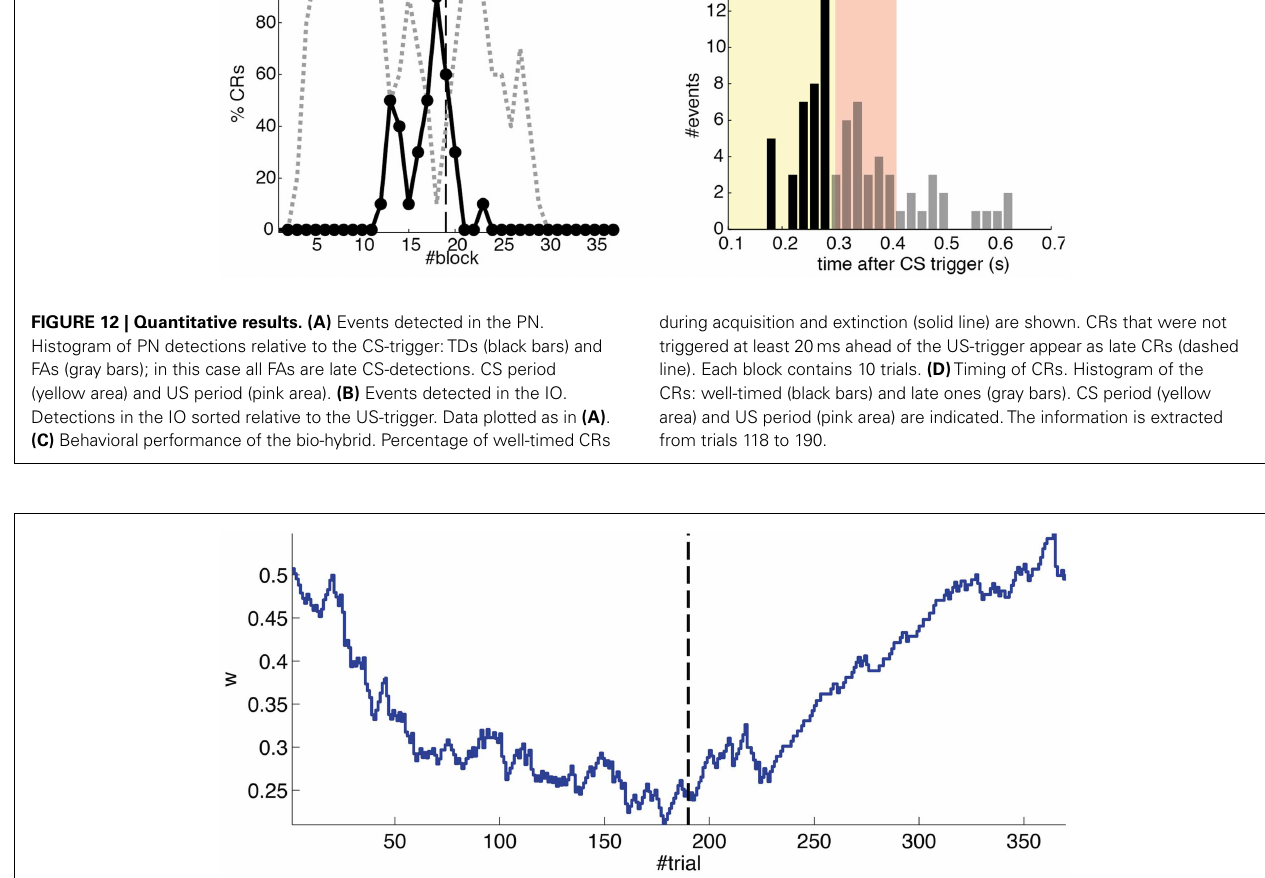
FIGURE 13 |Weight trajectory during the experiment. The dashed vertical line separates the acquisition and extinction